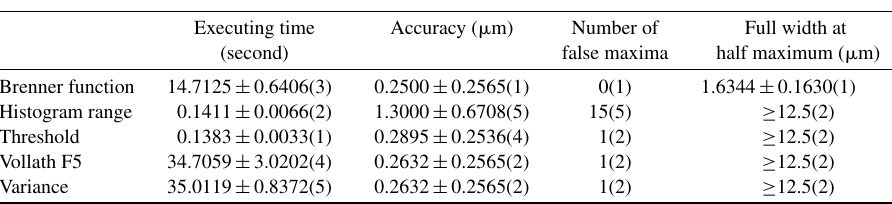
Results of the evaluation of autofocus functions for bone marrow specimen Executing